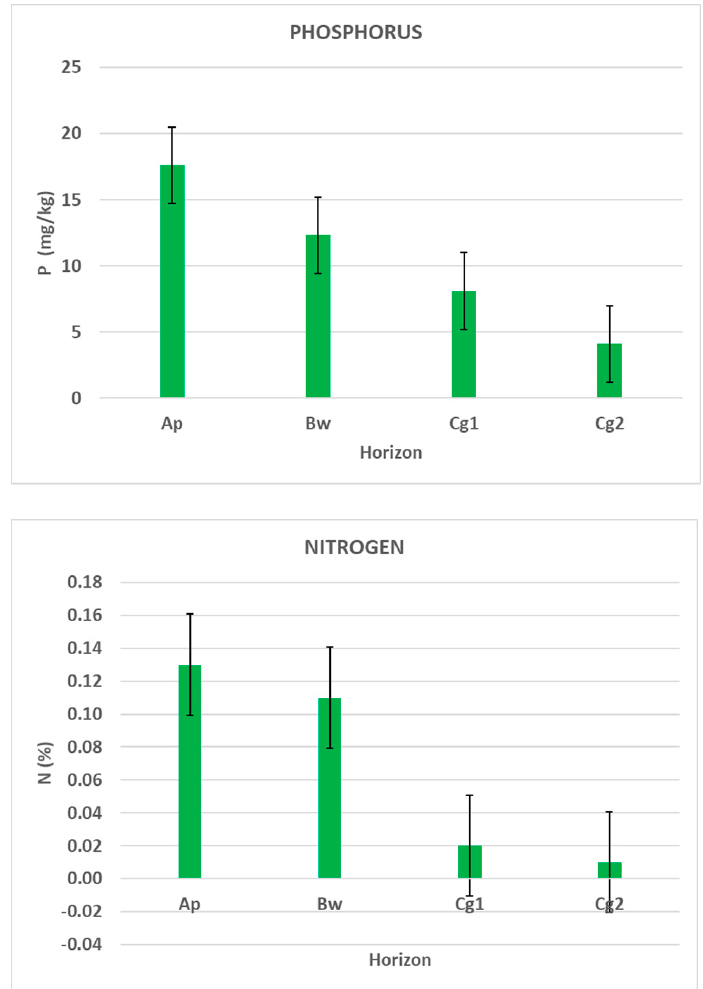
Figure 3. Graphs showing the contents of organic matter, phosphorus and nitrogen.